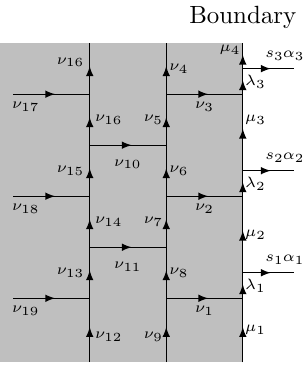
Figure 6 . A portion of the oriented trivalent lattice ~(cid:0) 0 on which the extended LW model is de(cid:12)ned. The bulk (grey region) is to the left of the boundary (consisting of the dangling